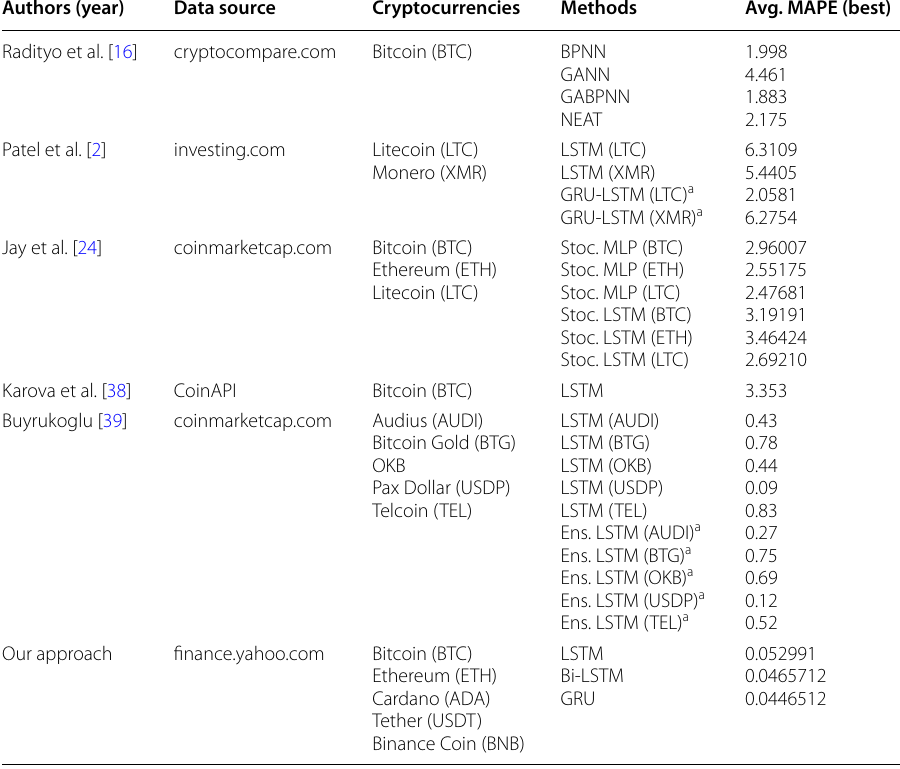
Table 5 Relative comparison with similar